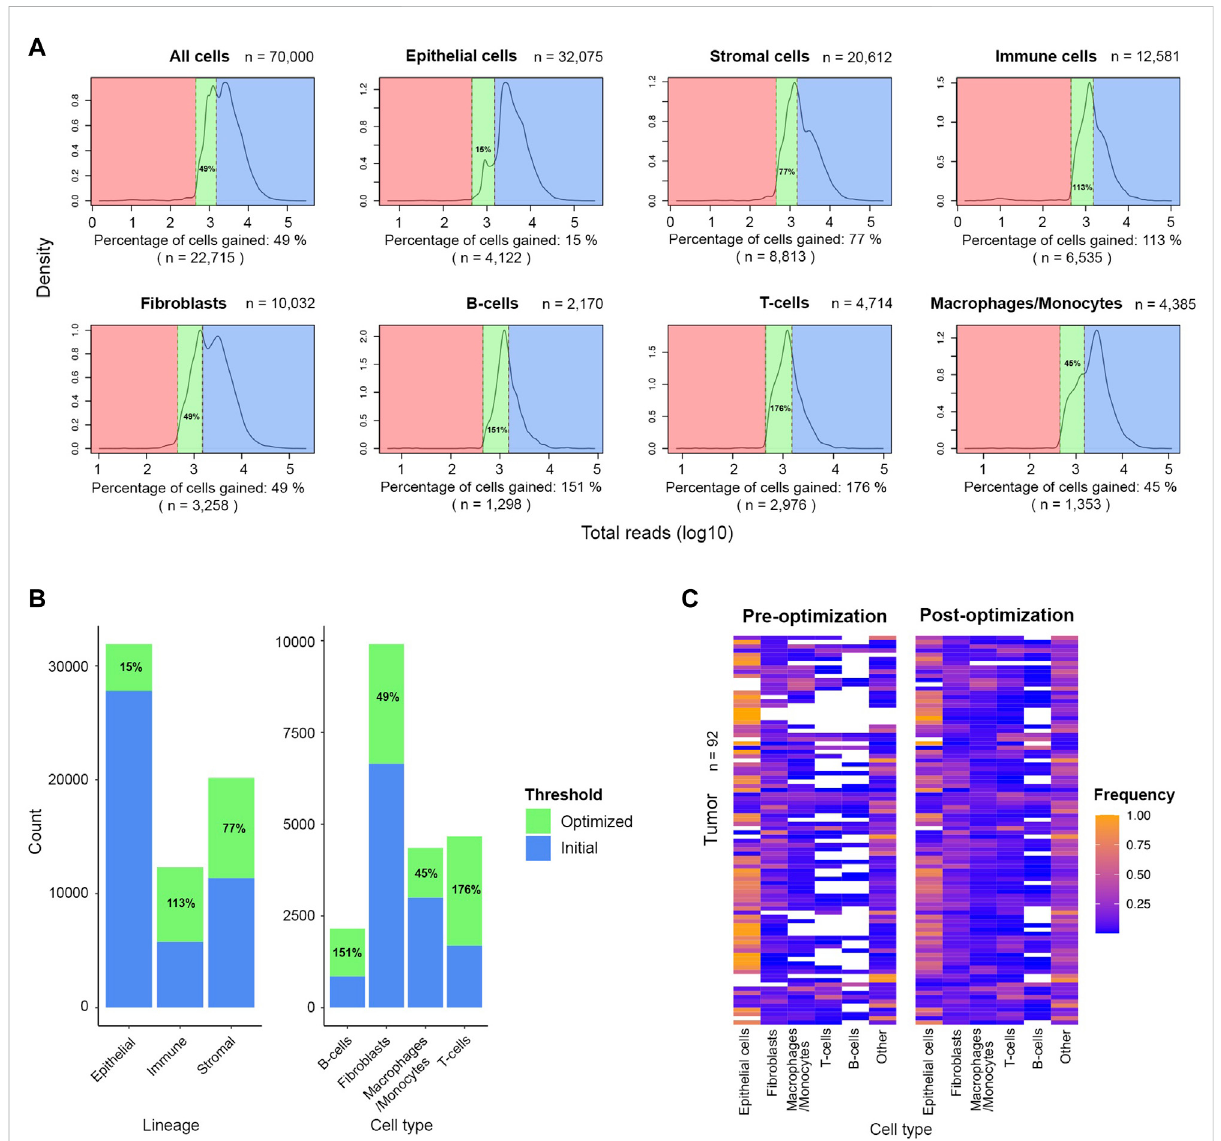
FIGURE 5 Signi fi cant number of stromal and immune cells are rescued after applying the optimized threshold of 450 UMIs in the FELINE dataset. (A) Density plots shows the UMI distribution across lineages and cell types within high- and low-quality cells subset ( n = 70,000). The initial threshold (1,500UMIs),dashedlinetotheright,andtheoptimizedthreshold(450UMIs),dashedlinetotheleft,areshownforeachplot.Theinitial “ high-quality ” cells, the rescued cells after applying the revised cut-off, and the low-quality cells are highlighted in blue, green, and red, respectively. The fractionandnumberofcellsgainedrelativetoinitiallyretainedcellsisdenotedundereachplot. (B) Barplotshowingthecellnumberandpercentage gain for lineage and cell types after applying the optimized threshold. (C) Heatmap showing the relative frequency of different cell types before and after applying the optimized UMI threshold of 450 in 92 tumor